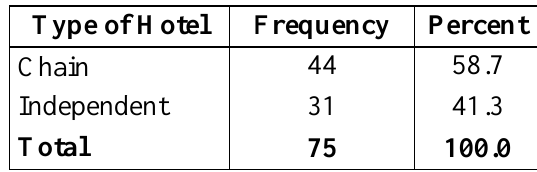
Table 3: Type of Hotel